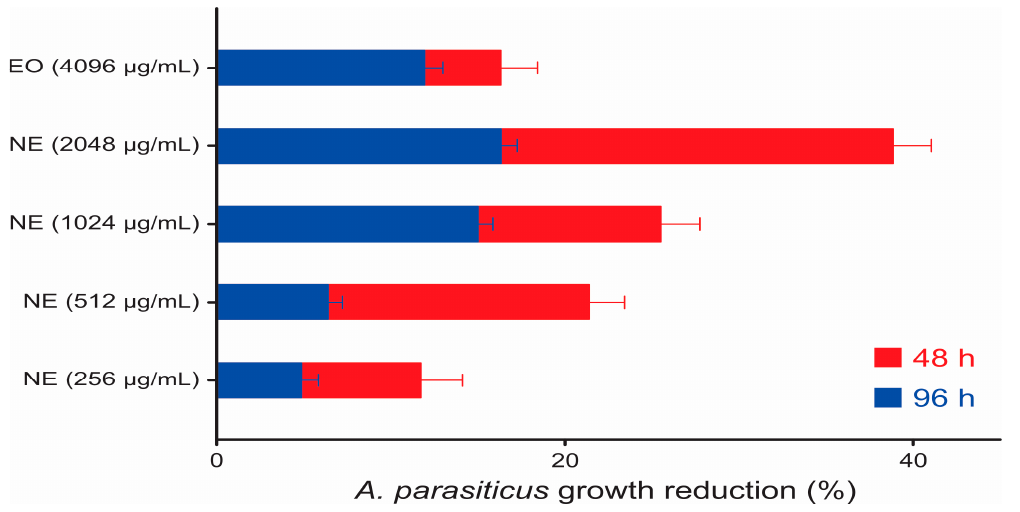
Figure 5. Inhibition of the A. parasiticus colonies by a concentration of the EO and the NE at 48 and 96 h.